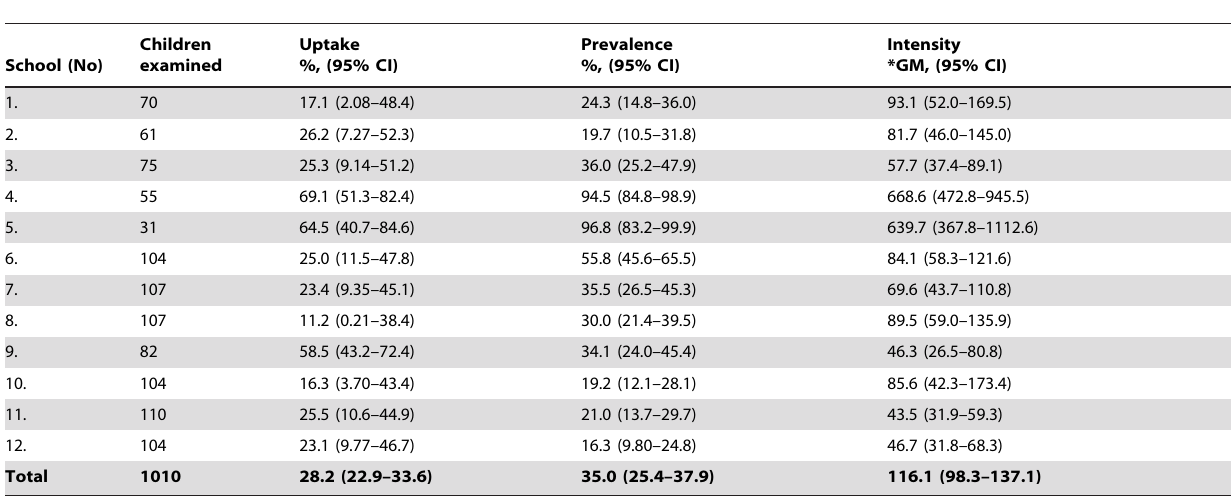
Table 1. Self-reported uptake of praziquantel, prevalence and intensity of S. mansoni infection in the 12 primary schools.